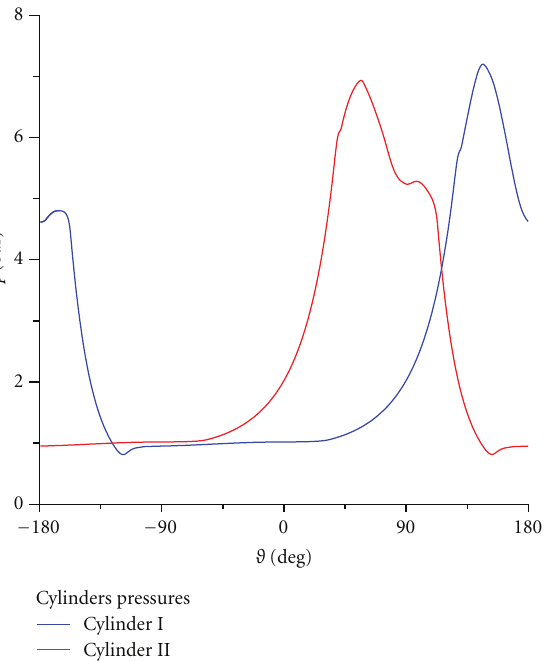
Figure 5: Comparison between numeric and experimental charac- teristic curves.